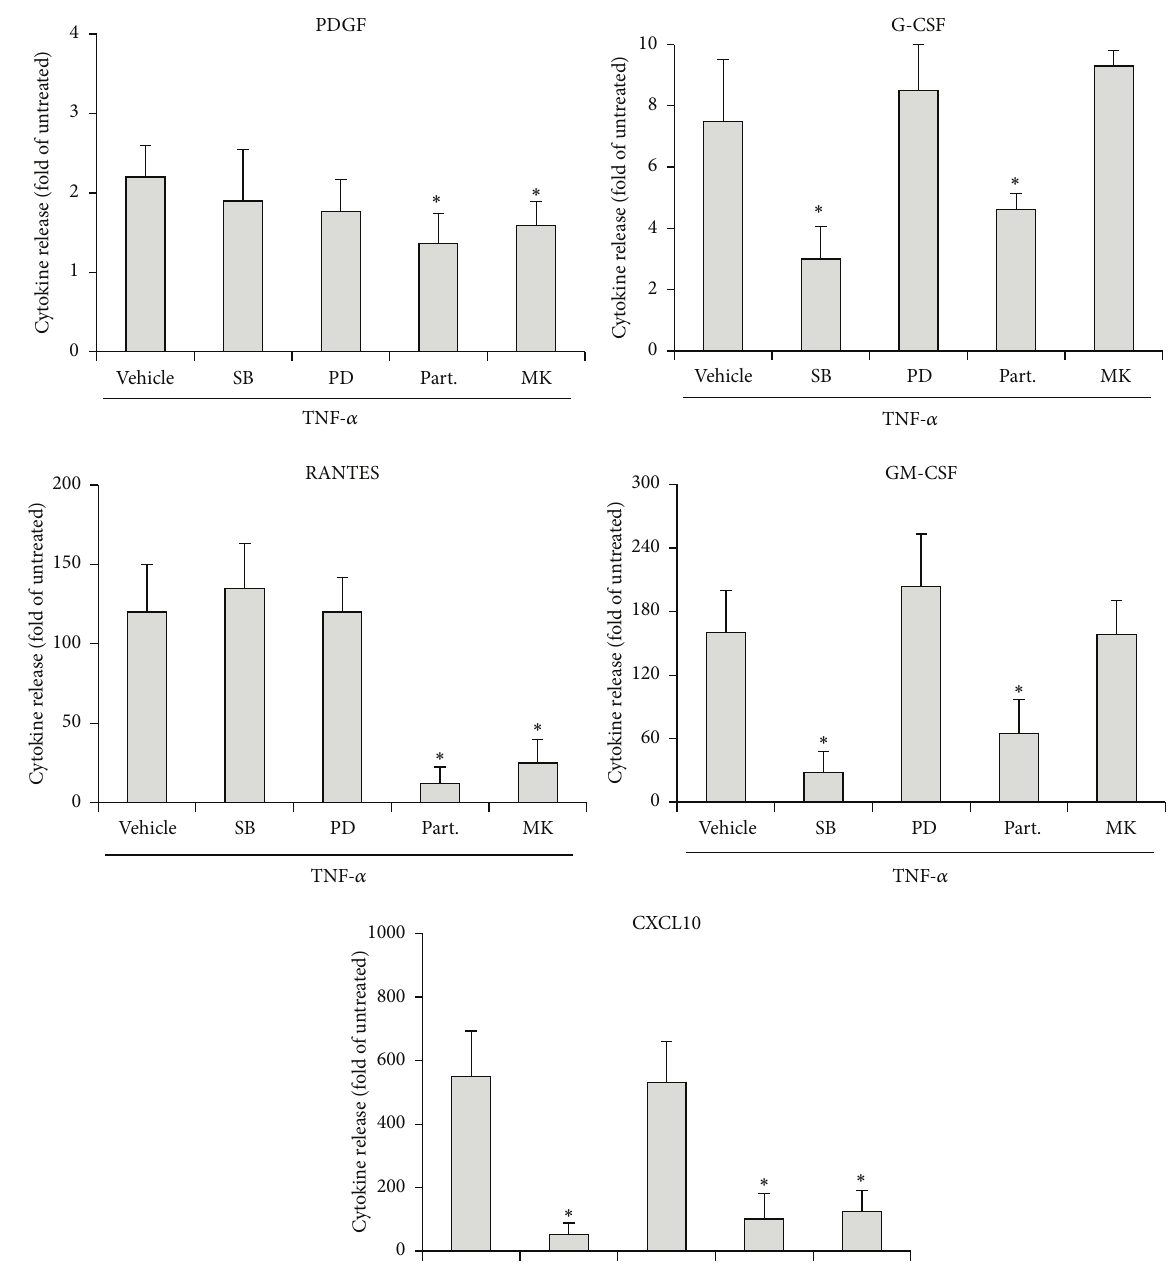
Figure 5: Differential effects of pharmacological inhibitors on cytokines/chemokines release in pathological VEC in response to TNF- 𝛼 . VEC were pretreated for 1 hour with SB203580 (10 𝜇 M), PD98059 (50 𝜇 M), Parthenolide (10 𝜇 M), SP600125 (5 𝜇 M), and MK-2206 (5 𝜇 M) before addition of TNF- 𝛼 (5ng/mL). After 24 hours, cell culture supernatants were analyzed for cytokines/chemokines release and normalized for cell number. Results are expressed as fold of induction with respect to untreated cultures (set to 1). Data are means ± SD of results obtained from four different experiments. ∗ 𝑃 < 0.05 compared to TNF- 𝛼 /vehicle treated